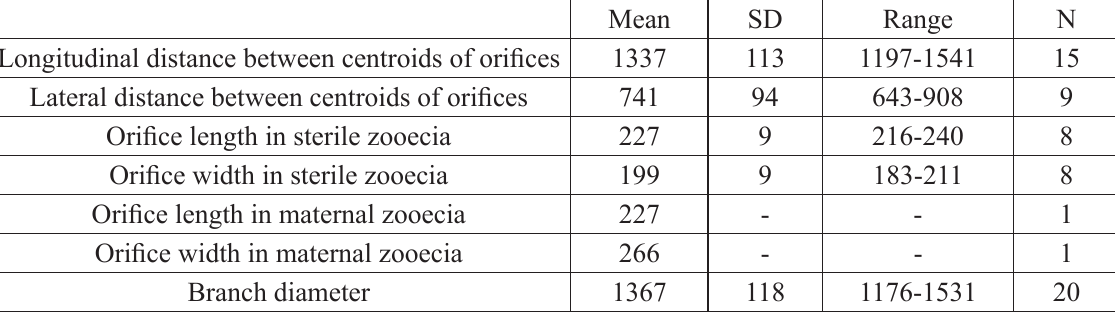
Table 4. Measurements (in µm) of skeletal characters of Myriapora bugei d’Hondt, 1975, taken from specimens MnHn iB-2013-3 (lectotype), MnHn 7481 (paralectotype), and MnHn iB-2013-2 (paralectotype). Branch width was measured on relatively mature branch regions; younger ones are distinctly narrower. As skeletal boundaries are invisible on the colony surface, ooecium dimensions could not be measured. SD = standard deviation, n = number of measurements. Mean SD range n Longitudinal distance between centroids of orifices 1337 113 1197-1541 15 Lateral distance between centroids of orifices 741 94 Orifice length in sterile zooecia 227 9 216-240 8 Orifice width in sterile zooecia 199 9 183-211 8 Orifice length in maternal zooecia 227 - - 1 Orifice width in maternal zooecia 266 - - 1 Branch diameter